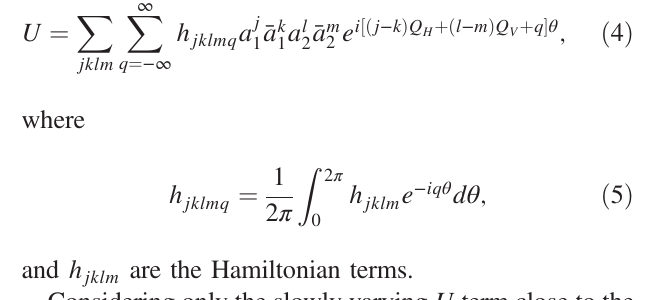
FIG. 1. LHC beam-beam tune footprint up to 6 beam sigma (in blue). Resonance lines up to 10th order are shown [4]. A 8 × 10 − 3 stopband is drawn in light red hypothetical Δ Q min ¼ to illustrate the reduction of the available resonance-free